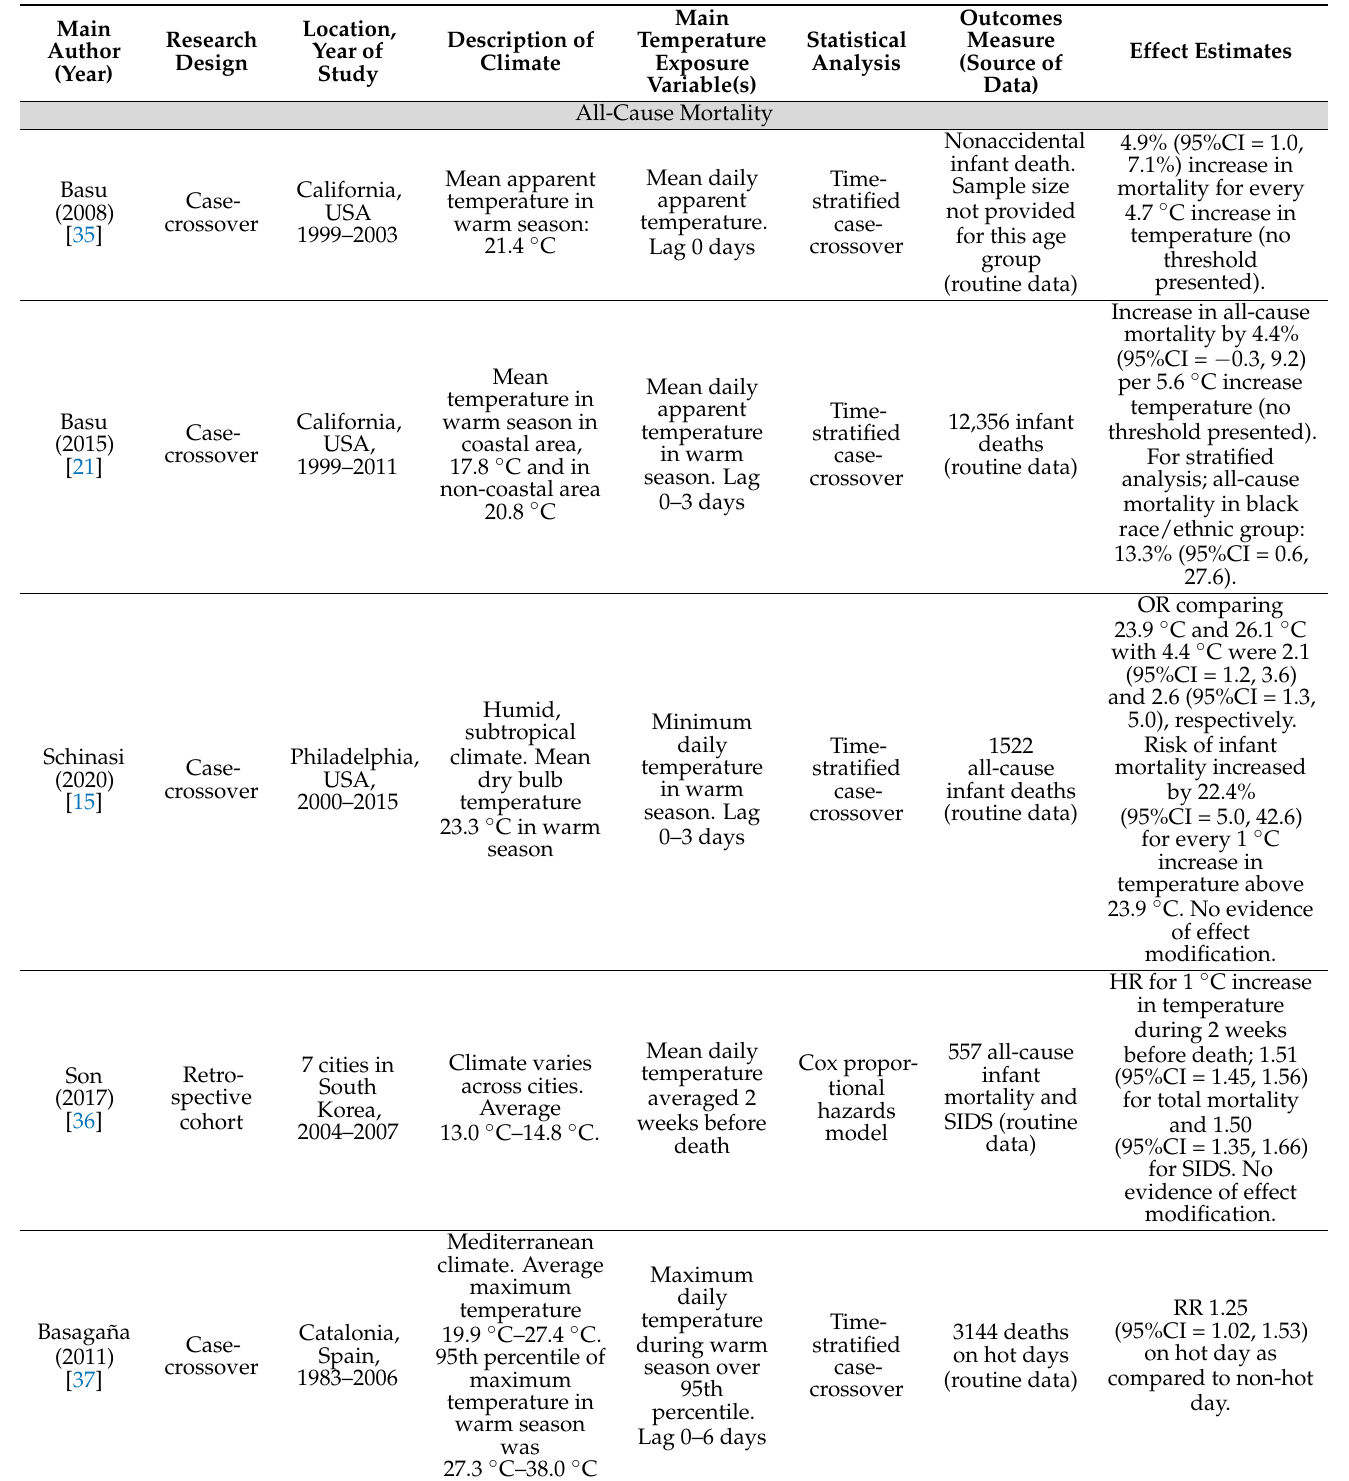
Table 2. Summary of study findings that assess temperature effects on all-cause infant mortality and